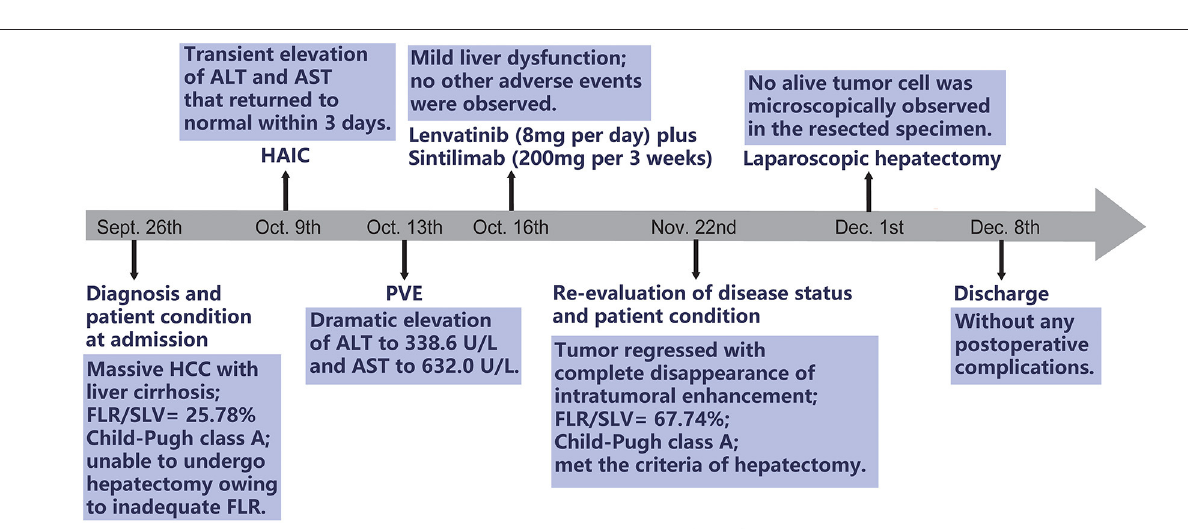
FIGURE 4 | Gross and histopathological findings of the resected specimen. The gross (A) and cut (B) surface of the tumor showed the solid tumor with obvious hemorrhage and necrosis. (C) Microscopic finding of the liver mass showed abundant infiltration of lymphocytes and complete tumoral necrosis without any viable alive tumor cells.